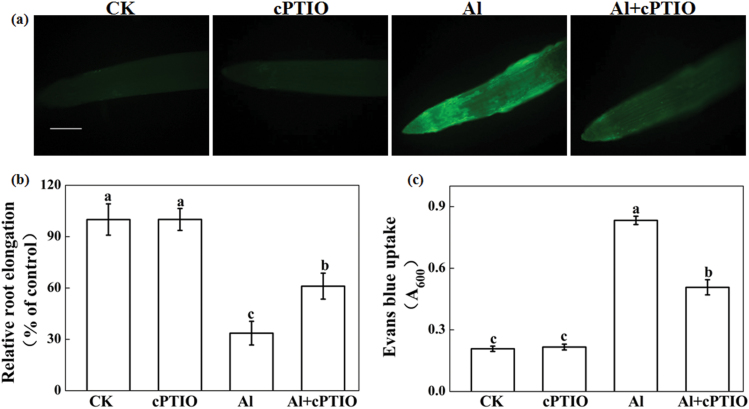
Effect of the NO scavenger cPTIO on NO content, root elongation, and Evans Blue uptake of wheat seedling roots with or without Al exposure. Three-day-old seedlings were treated with 30 μM Al and with or without 30 μM cPTIO for 24h. (a) Detection of NO fluorescence using DAF-FM DA staining and ﬂuorescence microscopy (n = 10). Scale bar, 1mm. (b) Root elongation was expressed relative to root elongation in control solutions of 0.5mM CaCl2, pH 4.3. Means ± SD (n = 20). (c) Seedling 10-mm root tips collected after 24h treatment were used to determine Evans Blue uptake. CK, 0.5mM CaCl2; cPTIO, 0.5mM CaCl2 + 30 μM cPTIO; Al, 0.5mM CaCl2 + 30 μM AlCl3; Al + cPTIO, 0.5mM CaCl2 + 30 μM AlCl3 + 30 μM cPTIO. Means ± SD (n = 3). Different letters indicate signiﬁcant differences (P < 0.05) among the treatments.